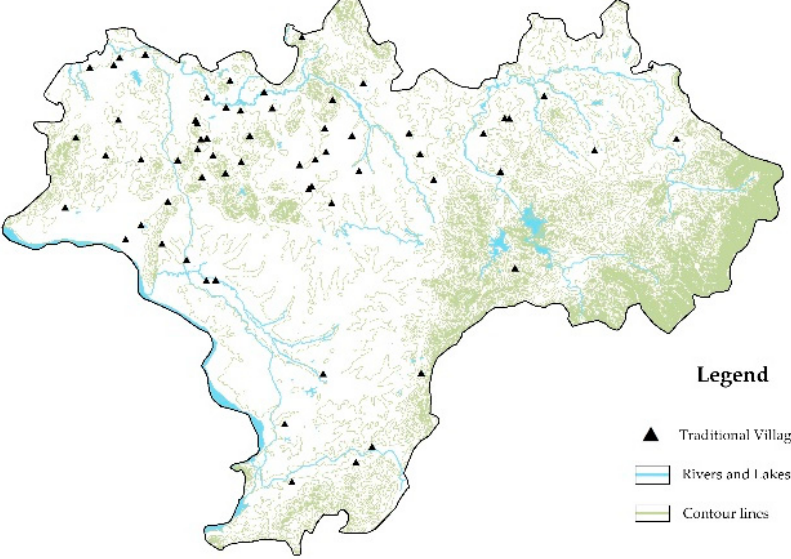
Table 1. Classification of the landscape pattern of traditional villages in Jinxi